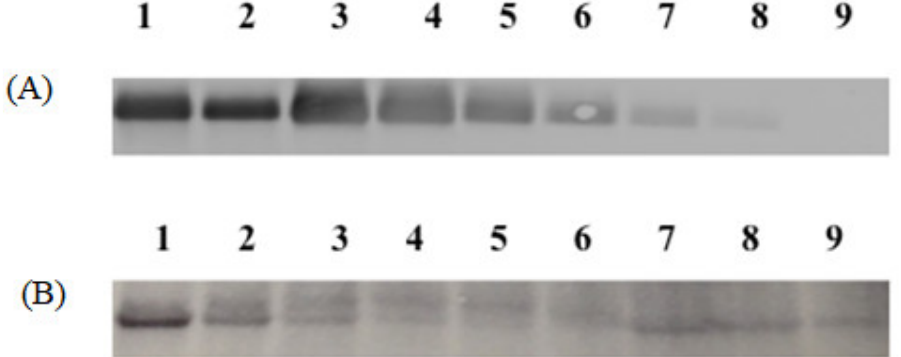
Figure 3. Transmission Electron Microscopy Images of Formulation 1 and Formulation 2. ( A ): For- mulation 1 contained 60% CPD and HPV16 VLP alone (prior to mixing with adjuvant MPs). ( B ): Formulation 2 contained 20% CPD, 5% vaccine and adjuvant loading HPV16 VLP, MPL and alum .